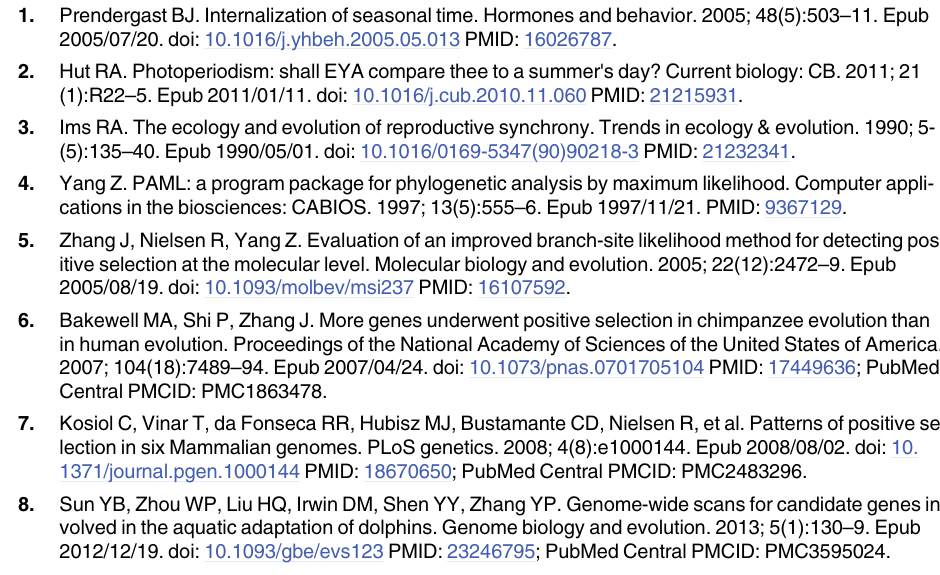
S1 Table. Positive sites mapped with the corresponding cDNA sequences. S2 Table. 1:1 gene orthologs. Gene orthologs were generated by BLAST, and the best hit of human versus the other species was then reversed. All identities were > 60%. S3 Table. Lengths of gene sequences before and after alignments with different aligners. S4 Table. Positive sites (BEB > 0.95). S5 Table. SP scores of positive sites after sequence alignment. S6 Table. Positive sites after SP-score filtering. S7 Table. Positive genes filtered by SP